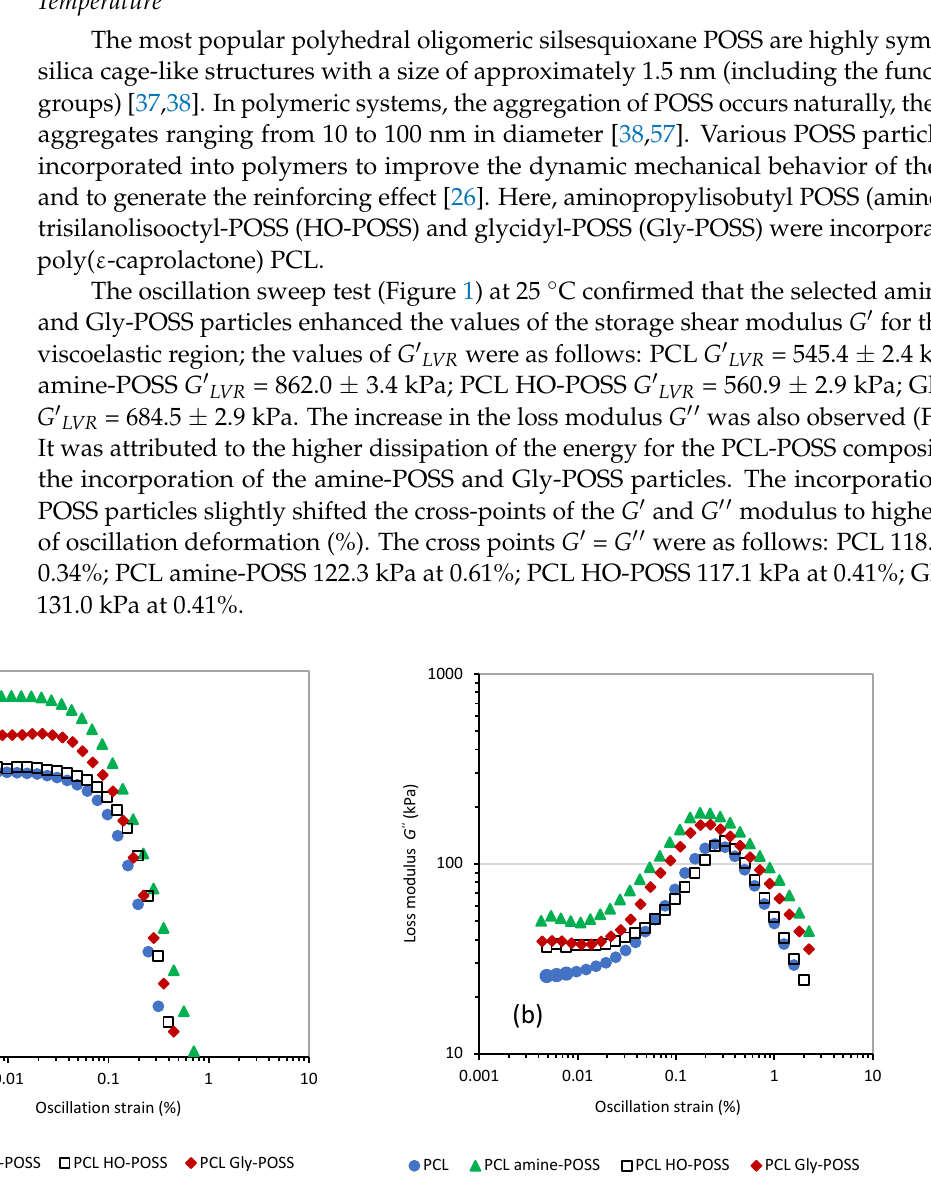
Figure 1. Viscoelastic properties of PCL modified by POSS additives. Storage shear modulus G ′ ( a ); loss shear modulus G ″ ( b ) as a function of oscillation strain. Temperature of the measurements 25 ° C, angular frequency 10 rad ⋅ s − 1 .